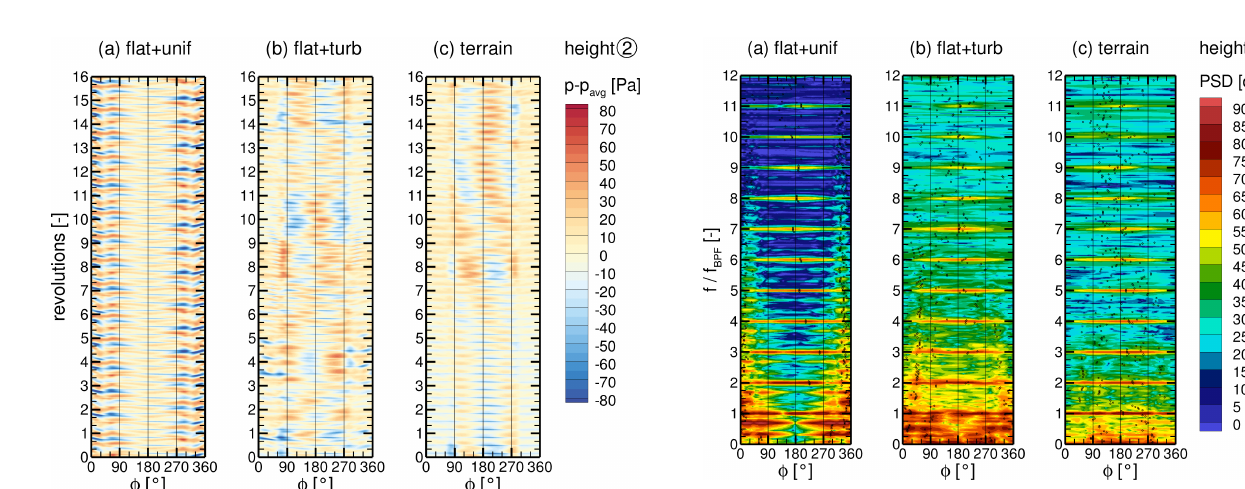
Figure 17. Time series of surface pressure fluctuations p − p avg on a line around the tower at height (2) for all cases (a) – (c) .